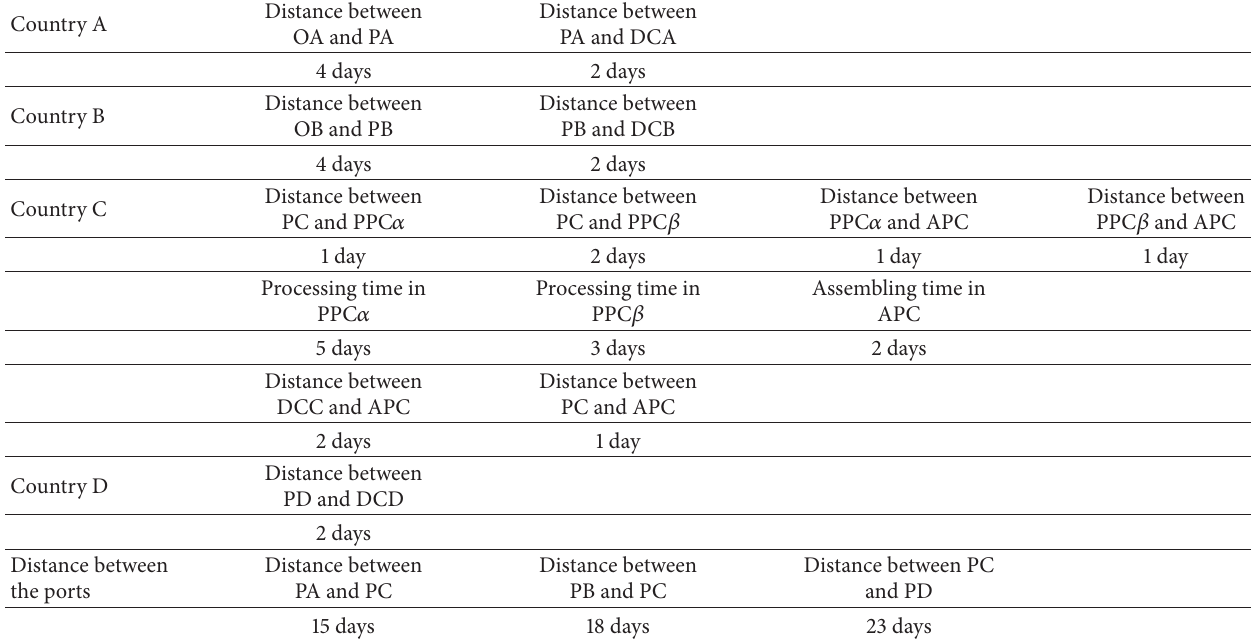
Table 2: Setting of parameters in Scheme 1.